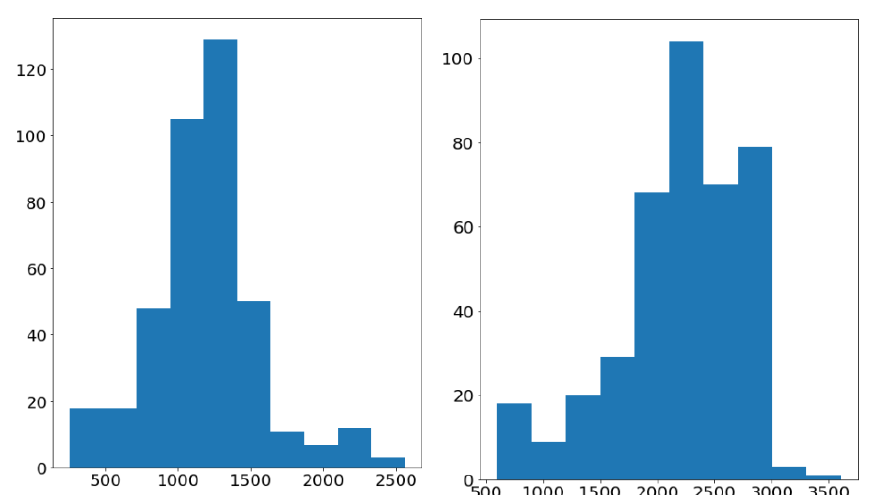
Figure 3. Data Distribution in the CNUH Dataset.